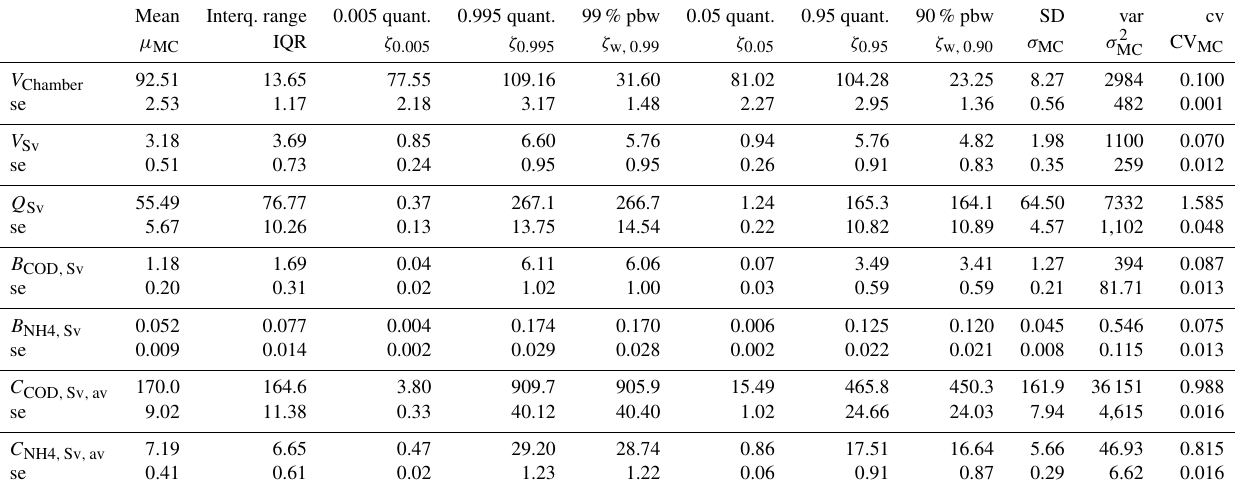
Table 4. Monte Carlo estimated statistics and standard errors (se) determined by bootstrapping for the MC simulations, where all selected input variables are uncertain R (model was run at 10min time steps, and MC results were aggregated to 1h averages over a 1 year period). See Appendix A for output variable nomenclature and units. Note: Interq. – interquartile; quant. – quantile; pbw – prediction band width; SD – standard deviation; var – variance; cv – coefficient of